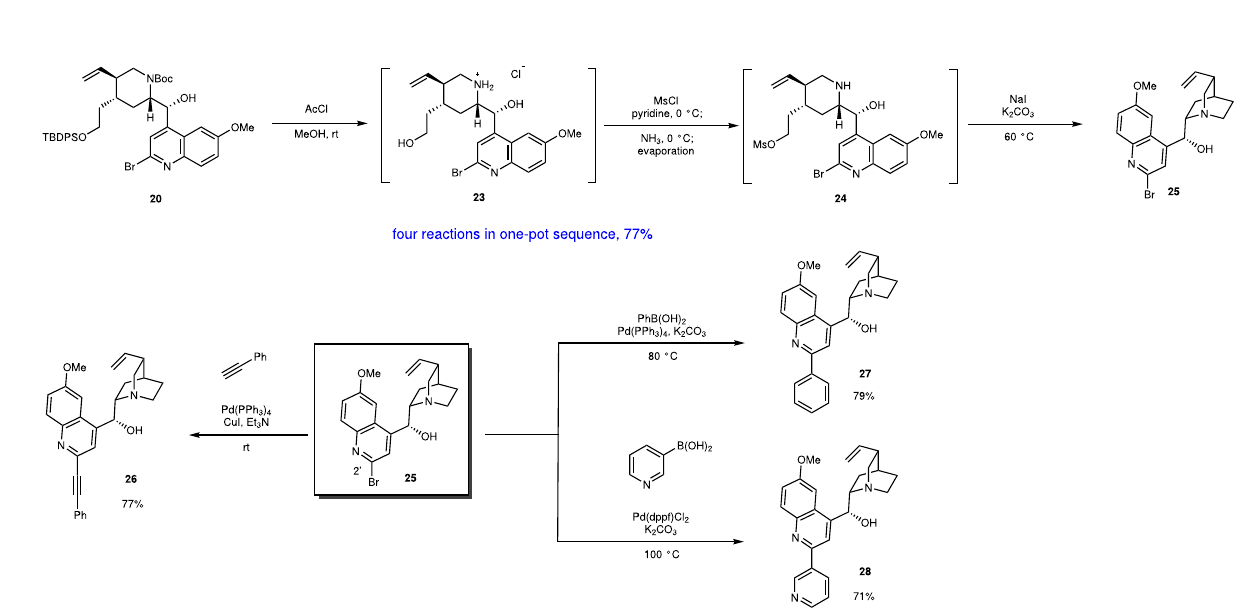
Fig. 8 | Derivatization of ( – )-quinine. 25 was synthesized from 20 in one-pot, and it could be converted to quinine derivatives 26 – 28 .